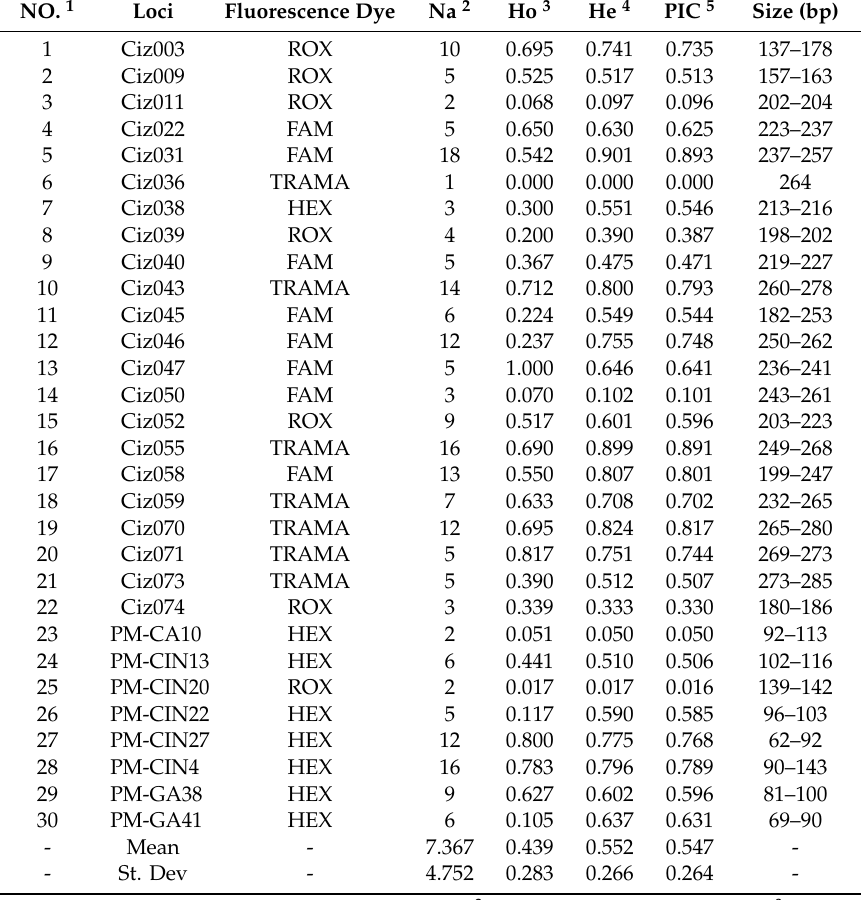
Table 3. The genetic characteristics of 30 SSR loci in 60 pecan